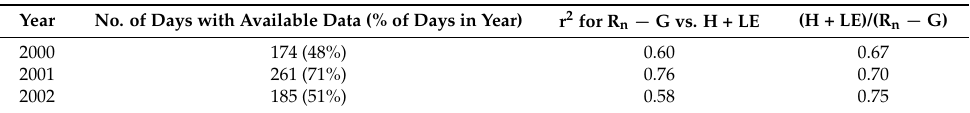
Table 4. Number of days with available data and as % of days of the year, regression coefficients and energy balance closure of the flux tower full dataset from RJA.